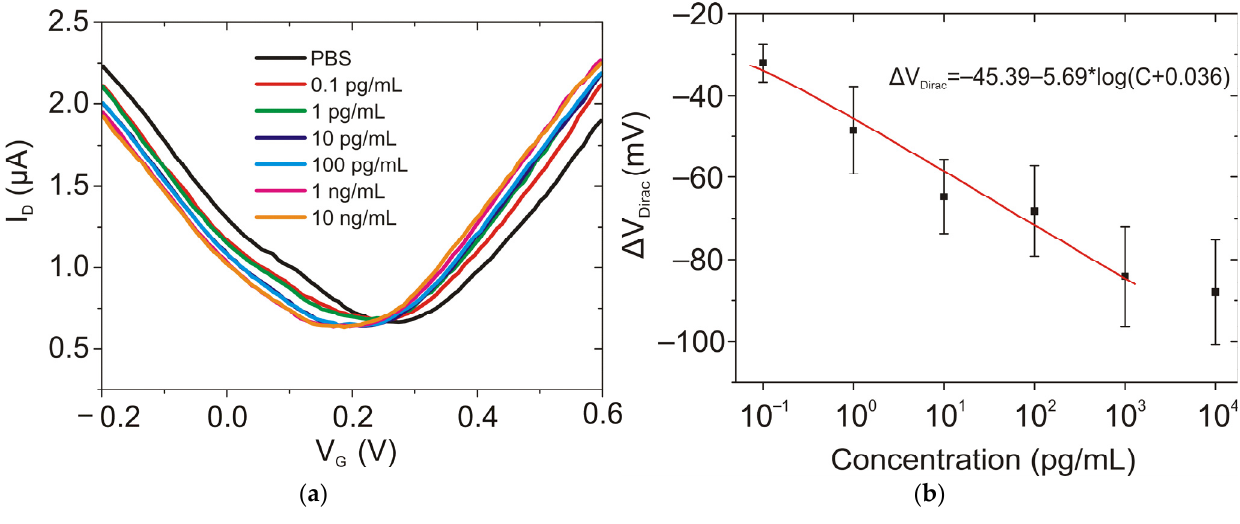
Table 1. The change in resistance (R), Dirac point, and G band intensities (I) after photochemical modification of graphene channel.